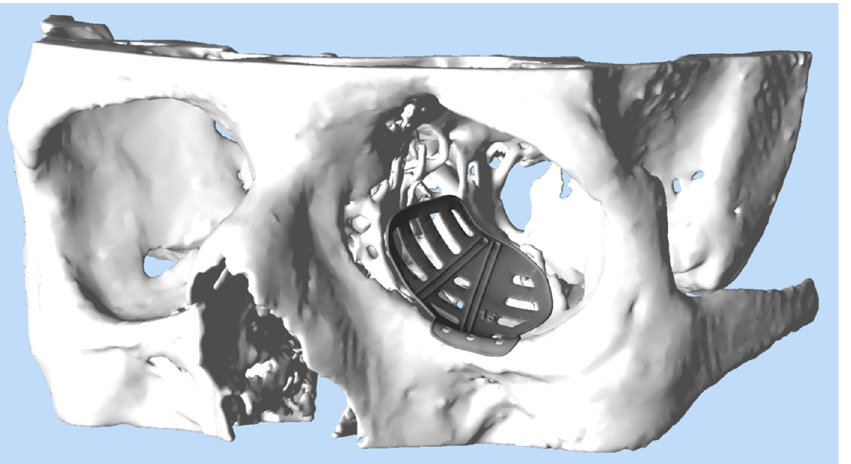
Figure 2. Virtual design of a PSI for reconstruction of the left orbit. The PSI (grey) has been provided with trajectory lines for intraoperative navigation and drain grooves to ensure postoperative drainage.